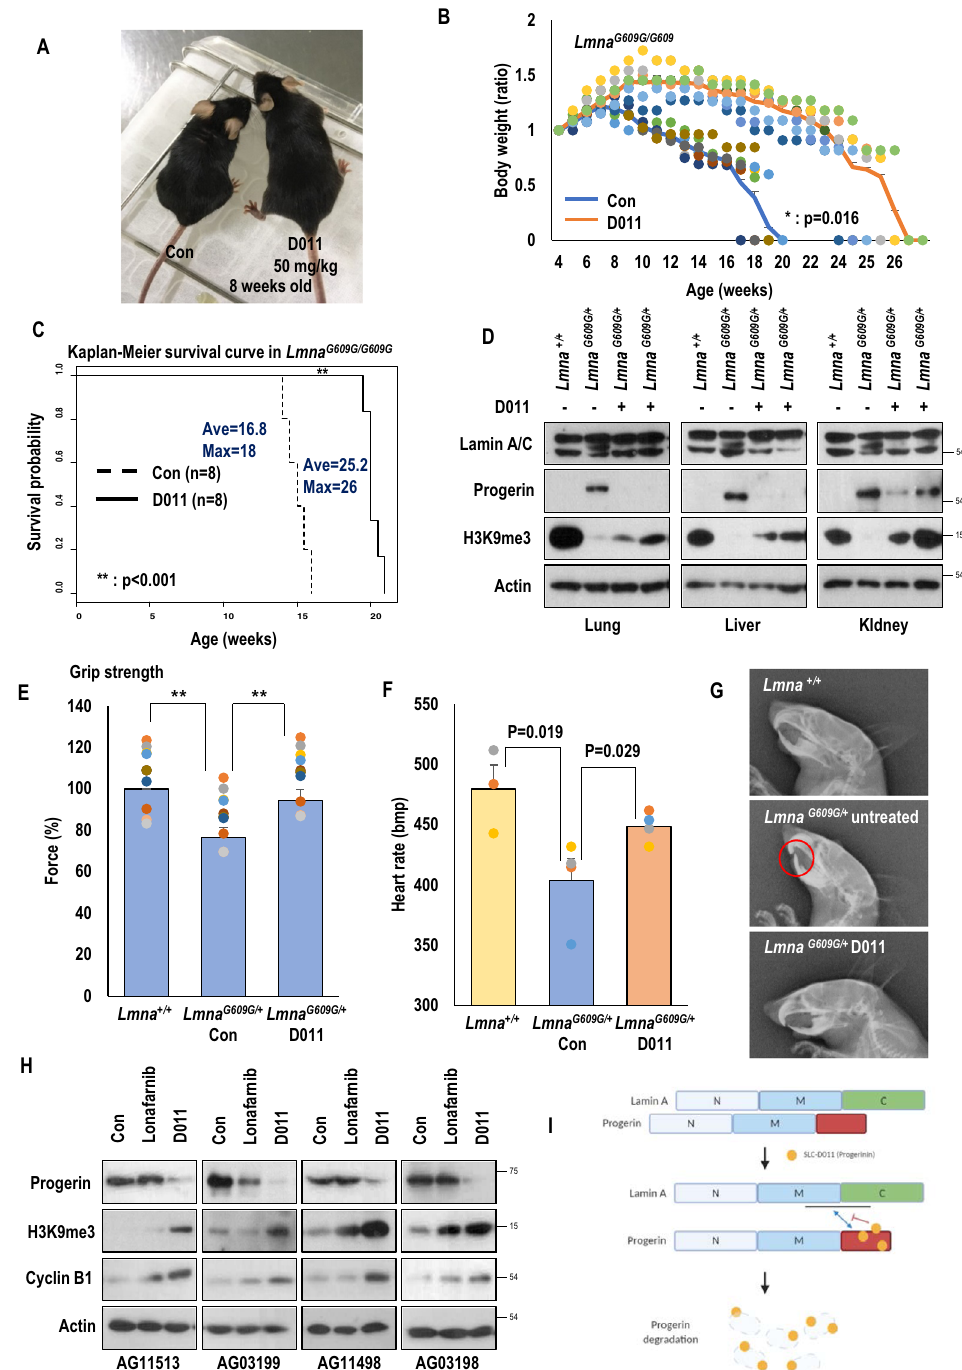
because of its rapid elimination in the body, JH4 was modi fi ed to a more stable form, SLC-D011 (also called progerinin). The C- terminal region of progerin was the direct target of progerinin (Fig. 4i) like JH4 17 . Interaction of progerinin with progerin interrupted the binding af fi nity of progerin to lamin A (Fig. 1c) and alleviated senescence features of HGPS cells including nuclear deformation and growth arrest (Figs. 1a – 1h and Figs. 2d – 2f). Moreover, administration of progerinin by i.p. injection ameliorated segmental progeroid phenotypes of Lmna G609G transgenic mice and extended the life span without toxicity (Fig. 3). However, it seemed that continuous injections caused stress to mice. Therefore, we administered progerinin